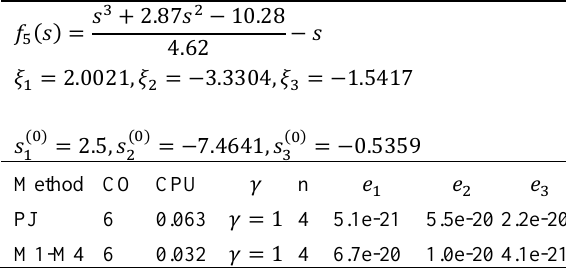
Simultaneous determination of all roots 𝑠 3 + 2.87𝑠 2 − 10.28 𝑓 5 (𝑠) = − 𝑠 4.62